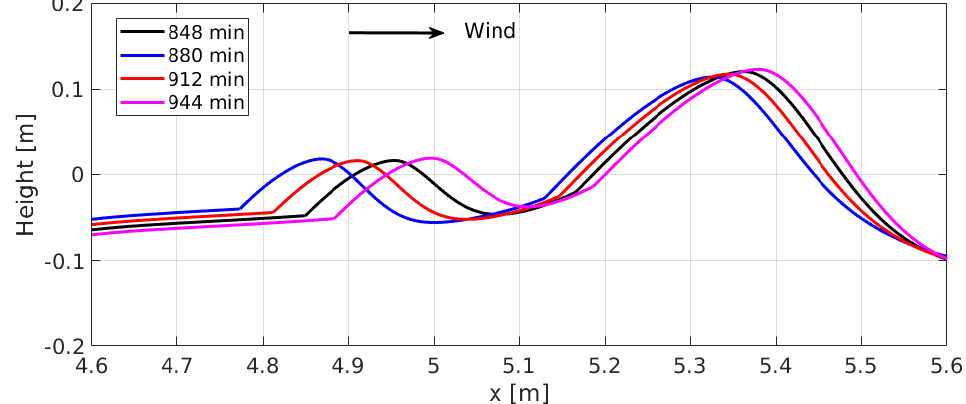
Figure 8. Small and large ripple migration between t = 848 min and t = 944 min. The small ripple moves downwind faster than the larger ripple due to its smaller volume.